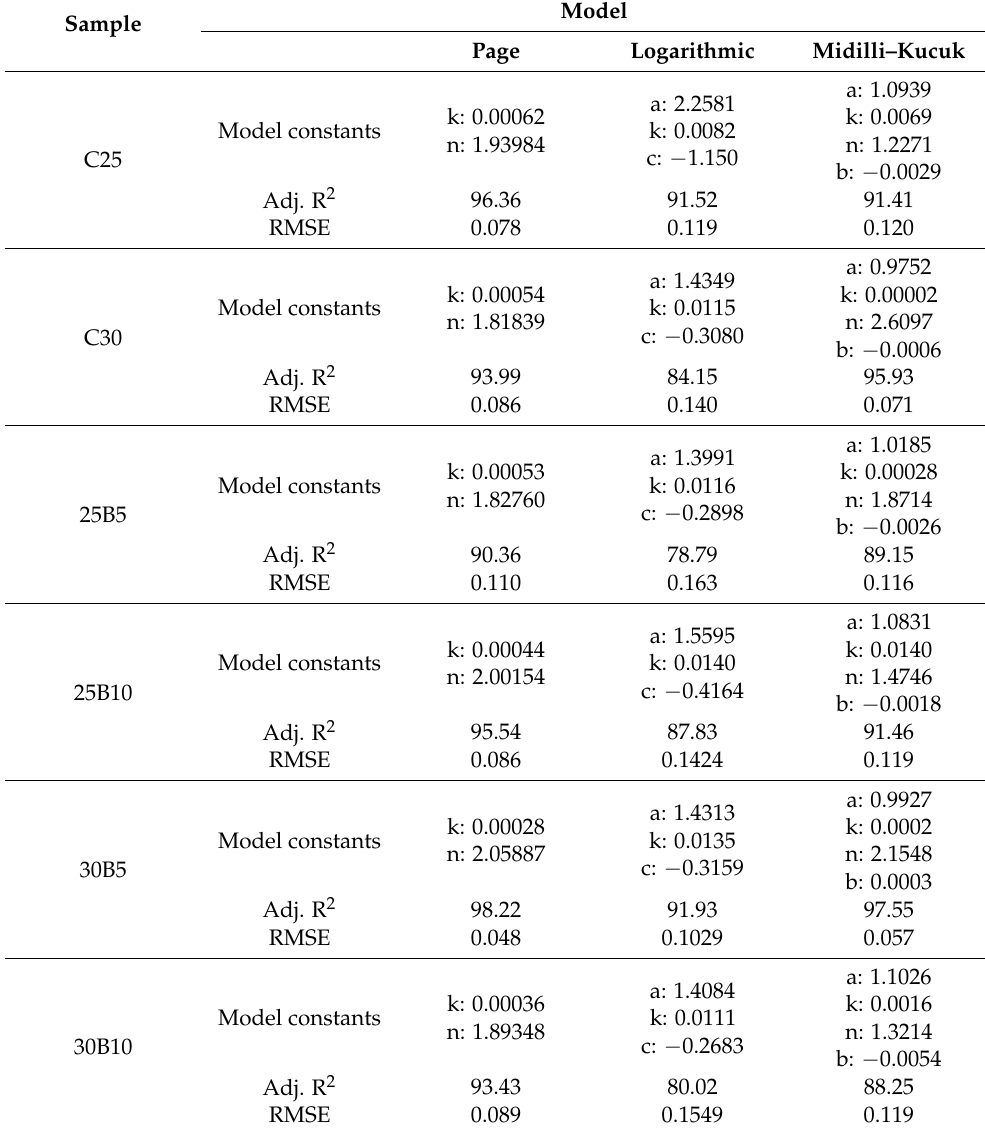
Table 1. Values of the microwaving expansion kinetic parameters obtained for pellets (C25: Control snack with 25% water content in mixture, C30: Control snack with 30% water content in mixture; C25B5: Snack with 25% water content and 5% beetroot content in mixture, C25B10: Snack with 25% water content and 10% beetroot content in mixture, C30B5: Snack with 30% water content and 5% beetroot content in mixture, and C30B10: Snack with 30% water content and 10% beetroot content in mixture) when the Page, Logarithmic, and Midilli–Kucuk models were used to fit the experimental data. Model Sample Page Logarithmic Midilli–Kucuk k: Model constants C25